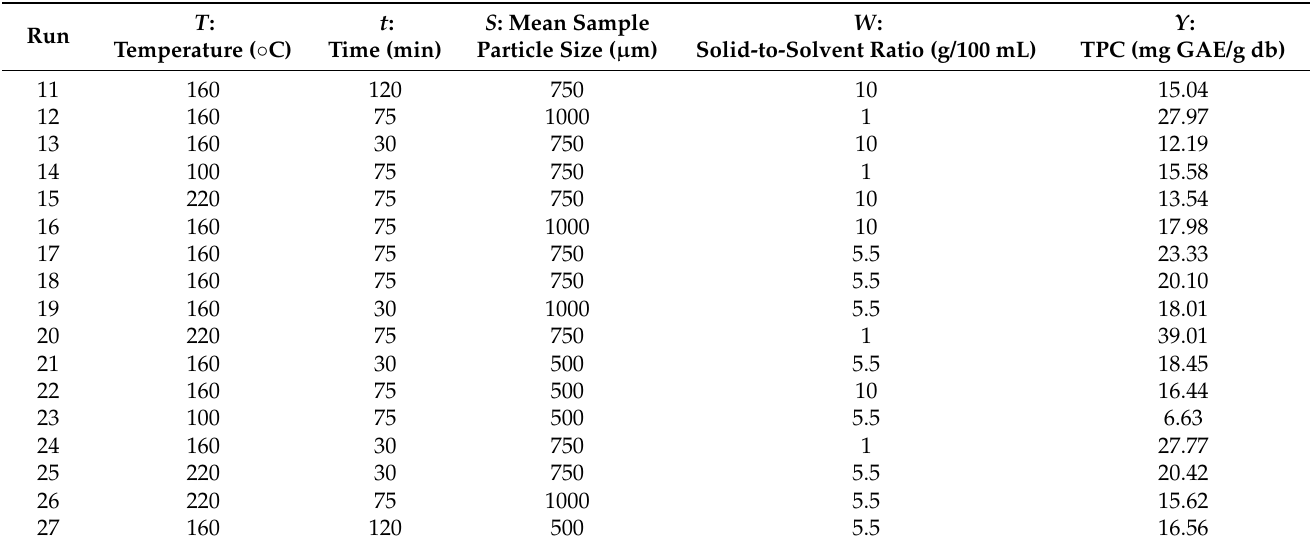
As the results exhibit (Table 3), the TPC content varied from 5.30 mg GAE/g db to 39.01 mg GAE/g db. The highest TPC was obtained at the conditions of extraction temperature, 220 ◦ C; solid-to-solvent ratio, 1 g/100 mL; extraction time, 75 min; and mean sample particle size of 750 µ m. The results revealed that the highest TPC content could be achieved at the highest temperature (220 ◦ C) and the lowest solid-to-solvent ratio (1 g/100 mL), indicating that temperature and solid-to-solvent ratio are two crucial factors affecting the efficiency of SCW of TPC from AP. An empirical quadratic model was developed based on the experimental data (Table 3) that exhibit the dependence of the TPC content on the process parameters presented in (Equation (1));